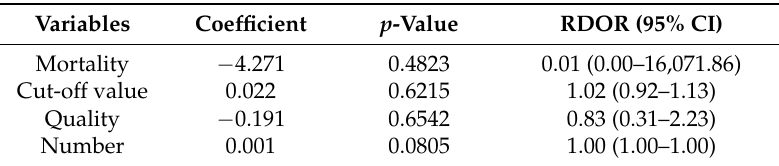
Table 4. Results of the meta-regression analysis.